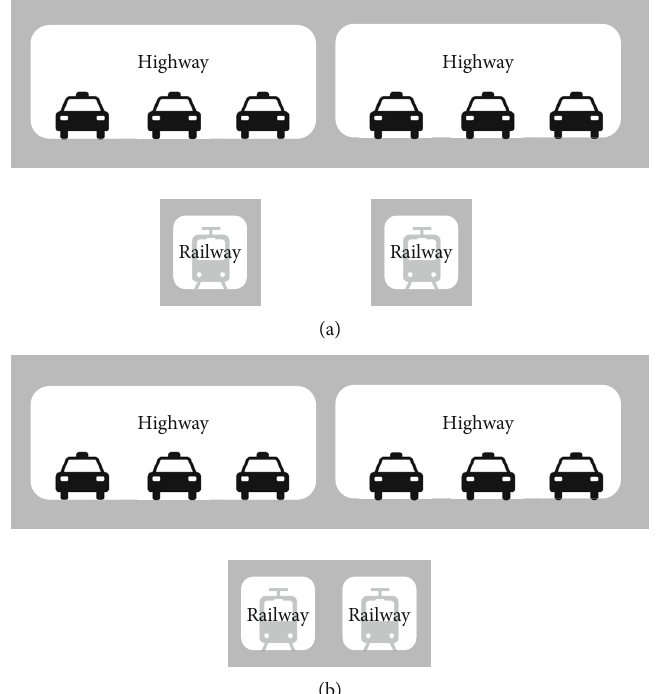
Figure 1: Structural form of Aixi Lake tunnel: (a) the west and east parts of the tunnel and (b) the middle part of the